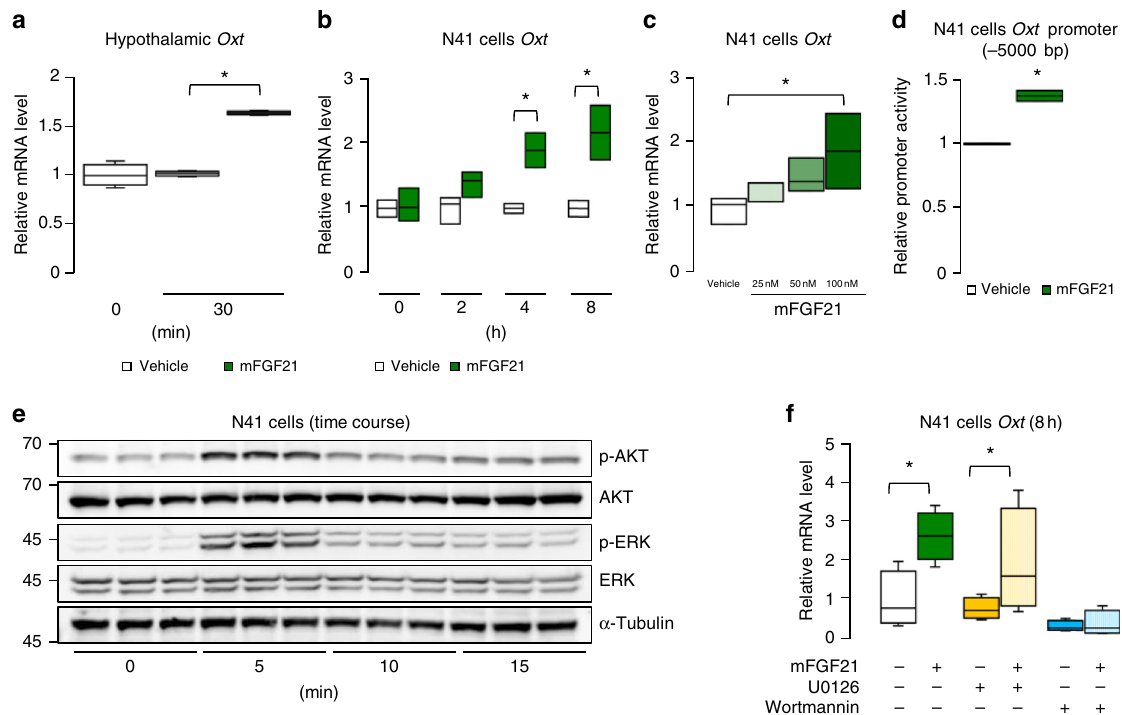
Fig. 6 FGF21 stimulates Oxt expression through AKT. a Hypothalamic Oxt mRNA expression levels after IP injection of mFGF21 (1 mg/kg) or water (vehicle) ( n = 4 per group). b , c The relative expression of Oxt mRNA in hypothalamic N41 cells after mFGF21 treatment: time-course data ( b ) and dose- response data ( c ) ( n = 3 per group). d Luciferase activity of Oxt promoter of − 5000bp in N41 cells was measured in response to 100 nM mFGF21 and vehicle (water) ( n = 3 per group). e Western blot analyses of N41 lysates after 100 nM mFGF21 treatment for 0, 5, 10 or 15 min ( n = 3 per time point). f Effect of inhibiting ERK signalling or AKT signalling on FGF21-induced Oxt expression. N41 cells underwent 30-min pre-treatment with or without the